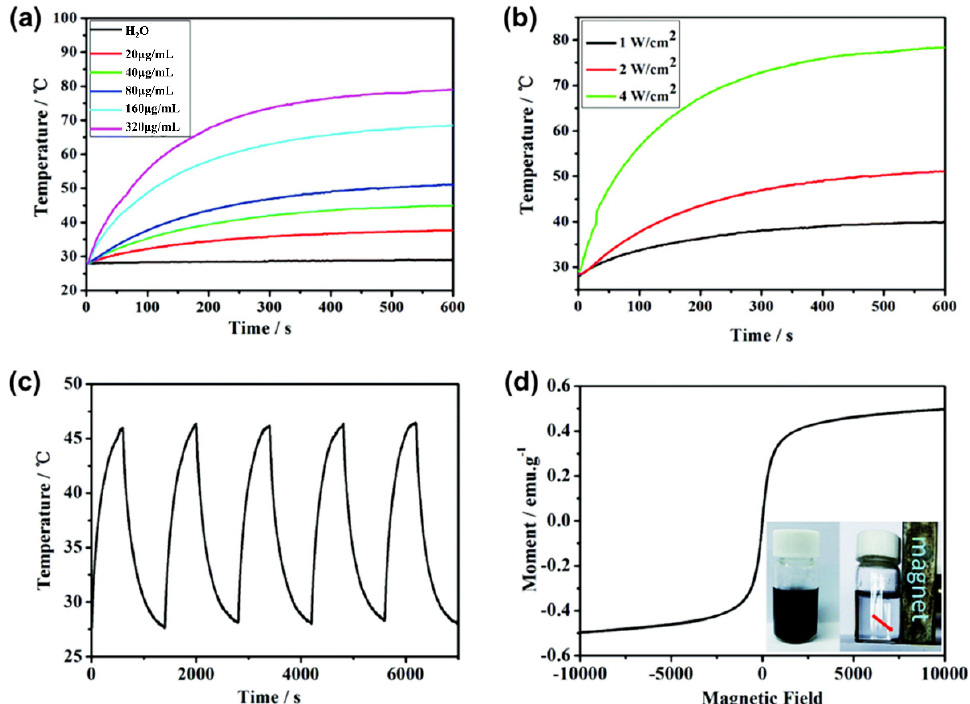
Figure 21. ( a ) Temperature profiles of ultrapure water and PMGNS solutions at different concentra- tions as a function of 808 nm laser irradiation for 10 min at a power density of 2 W cm − 2 . ( b ) Tem- perature profiles of PMGNS solutions at different powers as a function of 808 nm laser irradiation for 10 min at a concentration of 80 μ g mL − 1 . ( c ) Temperature monitoring of a PMGNS aqueous sus- pension at a concentration of 80 μ g mL − 1 during successive ON/OFF laser cycles at a power density of 2 W cm − 2 . ( d ) Magnetic hysteresis curves of PMGNSs attracted by a magnet. Reproduced with permission from reference [78].